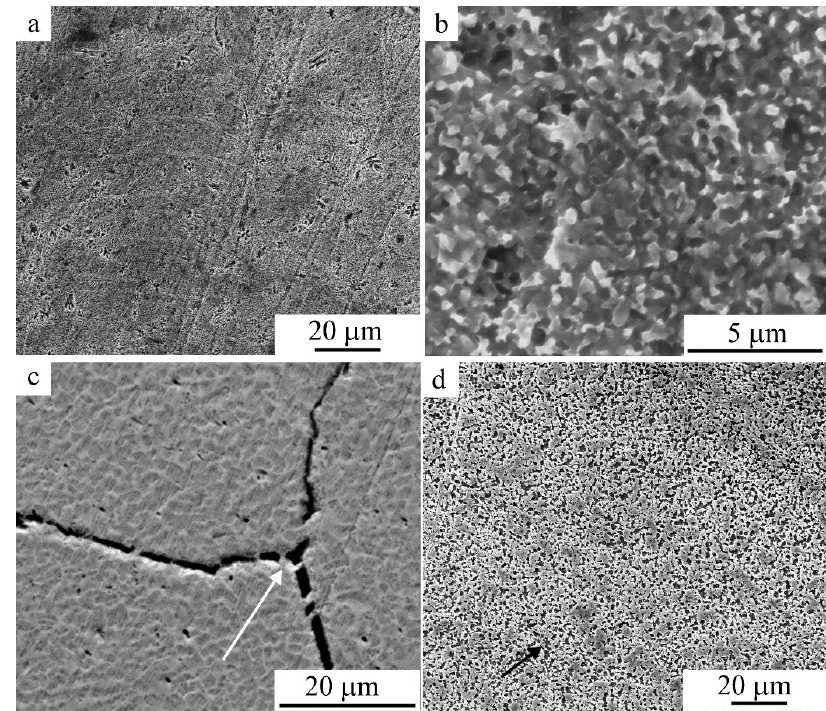
Figure 8. Secondary electron SEM images of the intragrain microstructure in the Cu-14Al-4Ni alloy after the compression tests at ( a , b ) 773 K ( v = 1 mm/min) and ( c , d ) 873 K (( c )— v = 5, ( d )— v = 1 mm/min).